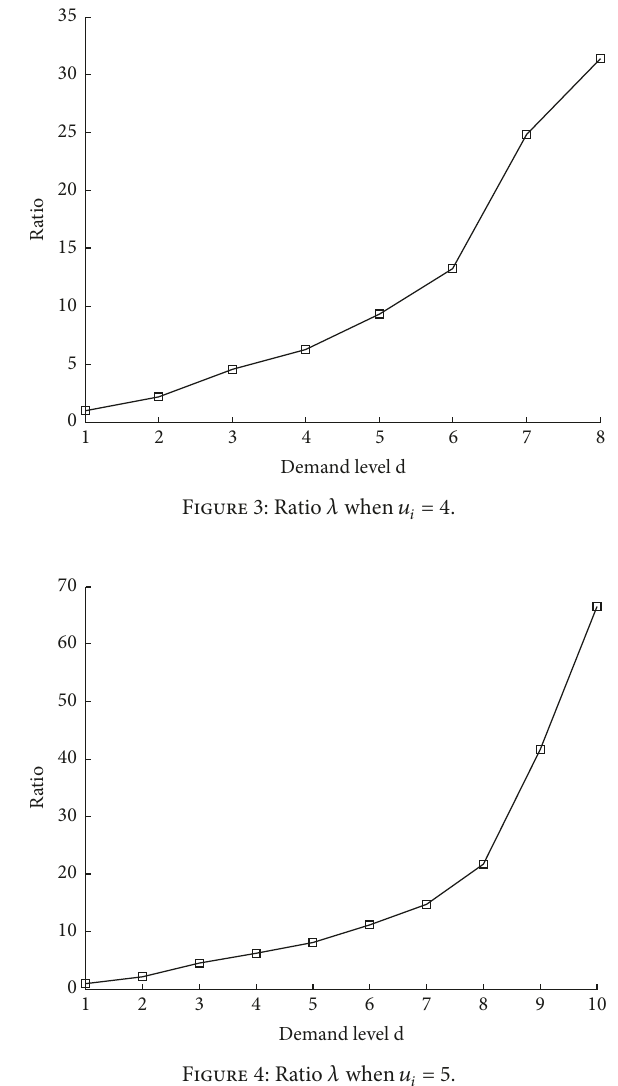
Figure 4: Ratio 𝜆 when 𝑢 𝑖 =